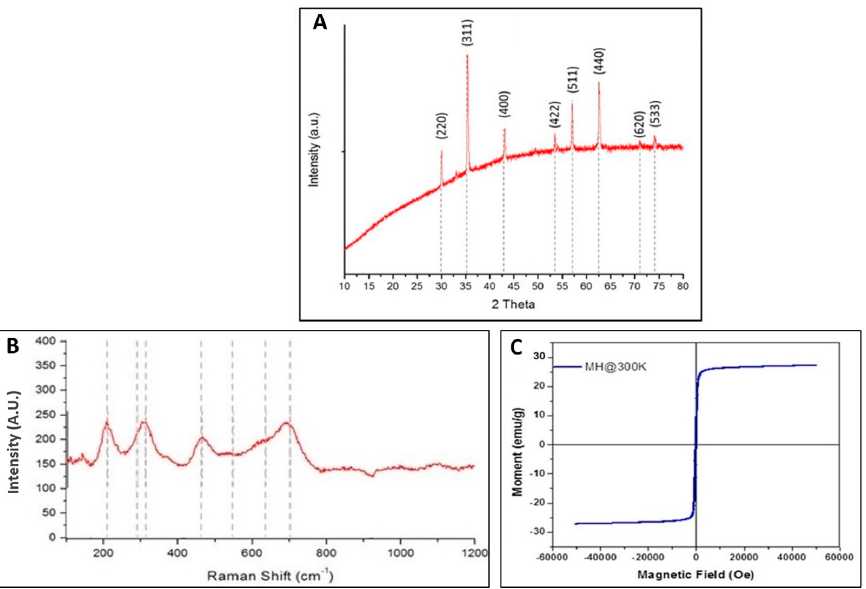
Figure 2. ( A ) X-Ray diffraction (XRD) pattern for the Mg-ferrite nanoparticles; ( B ) Raman spectra for the Mg-ferrite nanoparticles; and ( C ) Magnetization curve of Mg-ferrite nanoparticles. Raman spectra of the samples were recorded at room temperature within the range of 100–1200 cm − 1 , as shown in Figure 2B. The only features observed in this sample were associated with the spinel structure of Mg-ferrite. Cubic ferrites containing tetrahedral Fe 3+ O 4 were characterized by a strong Raman band in the 660–720 cm − 1 region assigned to the A 1g mode. Here, the peak at 705 cm − 1 was assigned to the A 1 g mode of the Mg-ferrite nanoparticles [33]. Figure 2C displays the magnetization versus applied field curve for Mg-ferrite sample. The absence of hysteresis and remanence in the hysteresis loop indicated superparamagnetic properties at 300 K for Mg-ferrite nanoparticles [34]. The saturation magnetization for Mg-ferrite nanoparticles was 27.1 emu/g. Holec et al. reported Mg- ferrite nanoparticles by the reverse micelle method with saturation magnetization of 32 emu/g [35].